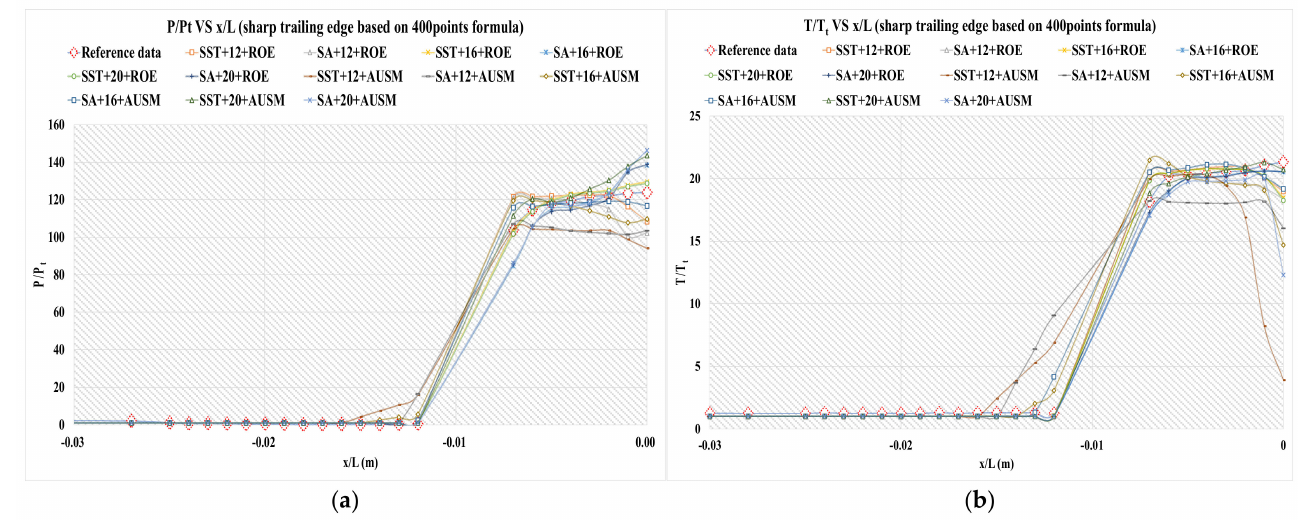
Figure 20. ( a ) Distributions of P/P t of sharp trailing edge based on 400 points formula; ( b ) Distribu- tions of T/T t of sharp trailing edge based on 400 points formula.